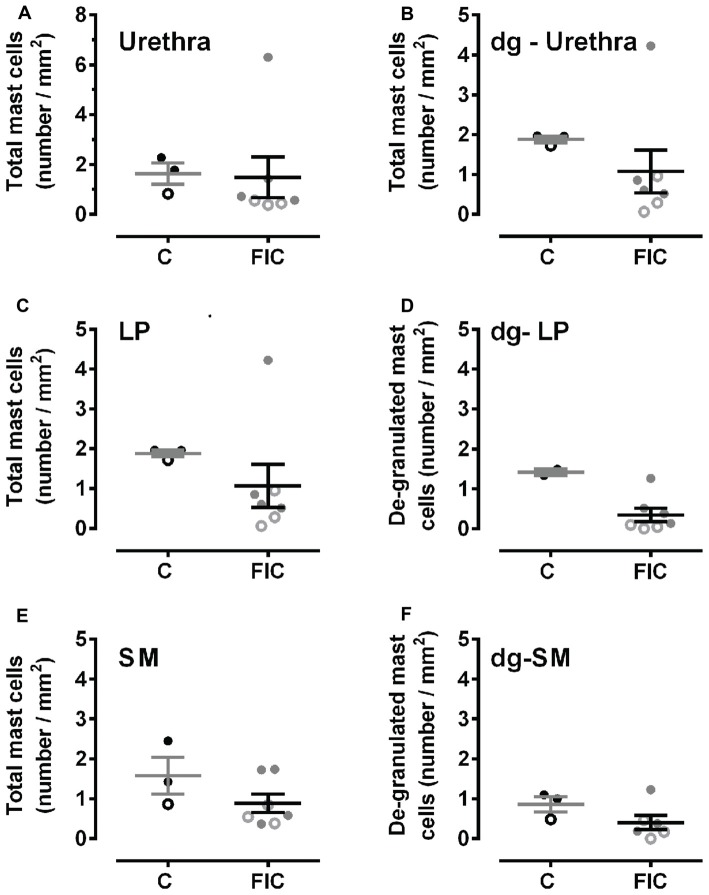
Mast cell quantification in urethral tissue from control and FIC cats. Data are presented as single points from individual cats with mean ± SEM. Control cats (n = 3) are shown in black and FIC (n = 7) in gray. Statistical significance was tested using Mann-Whitney test. (A) Total number of mast cells, including granulated and de-granulated (dg-), in the urethral tissue which is comprised of LP and SM in control and FIC tissue (p = 0.18). (B) Total number of de-granulated mast cells in the whole urethra in control and FIC tissue (p = 0.60). (C) Total number of mast cells in the LP in control and FIC tissue (p = 0.11). (D) Total number of de-granulated mast cells in the LP in control and FIC tissue (p = 0.55). (E) Total number of mast cells in the SM in control and FIC tissue (p = 0.18). (F) Total number of de-granulated mast cells in the SM in control and FIC tissue (p = 0.16). In all panels, each symbol represents data from one animal. Open circles represent males, closed circles females and open squares represent undocumented sex.